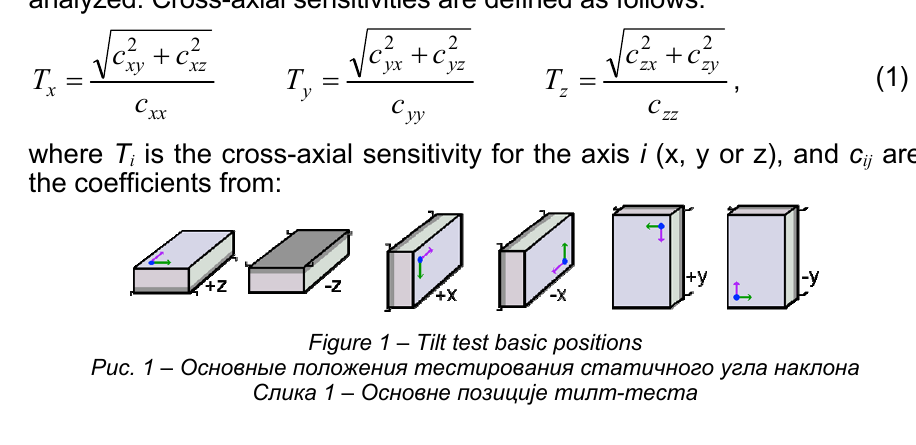
Figure 1 – Tilt test basic positions Рис . 1 – Основные положения тестирования статичного угла наклона Слика 1 – Основне позиције тилт -